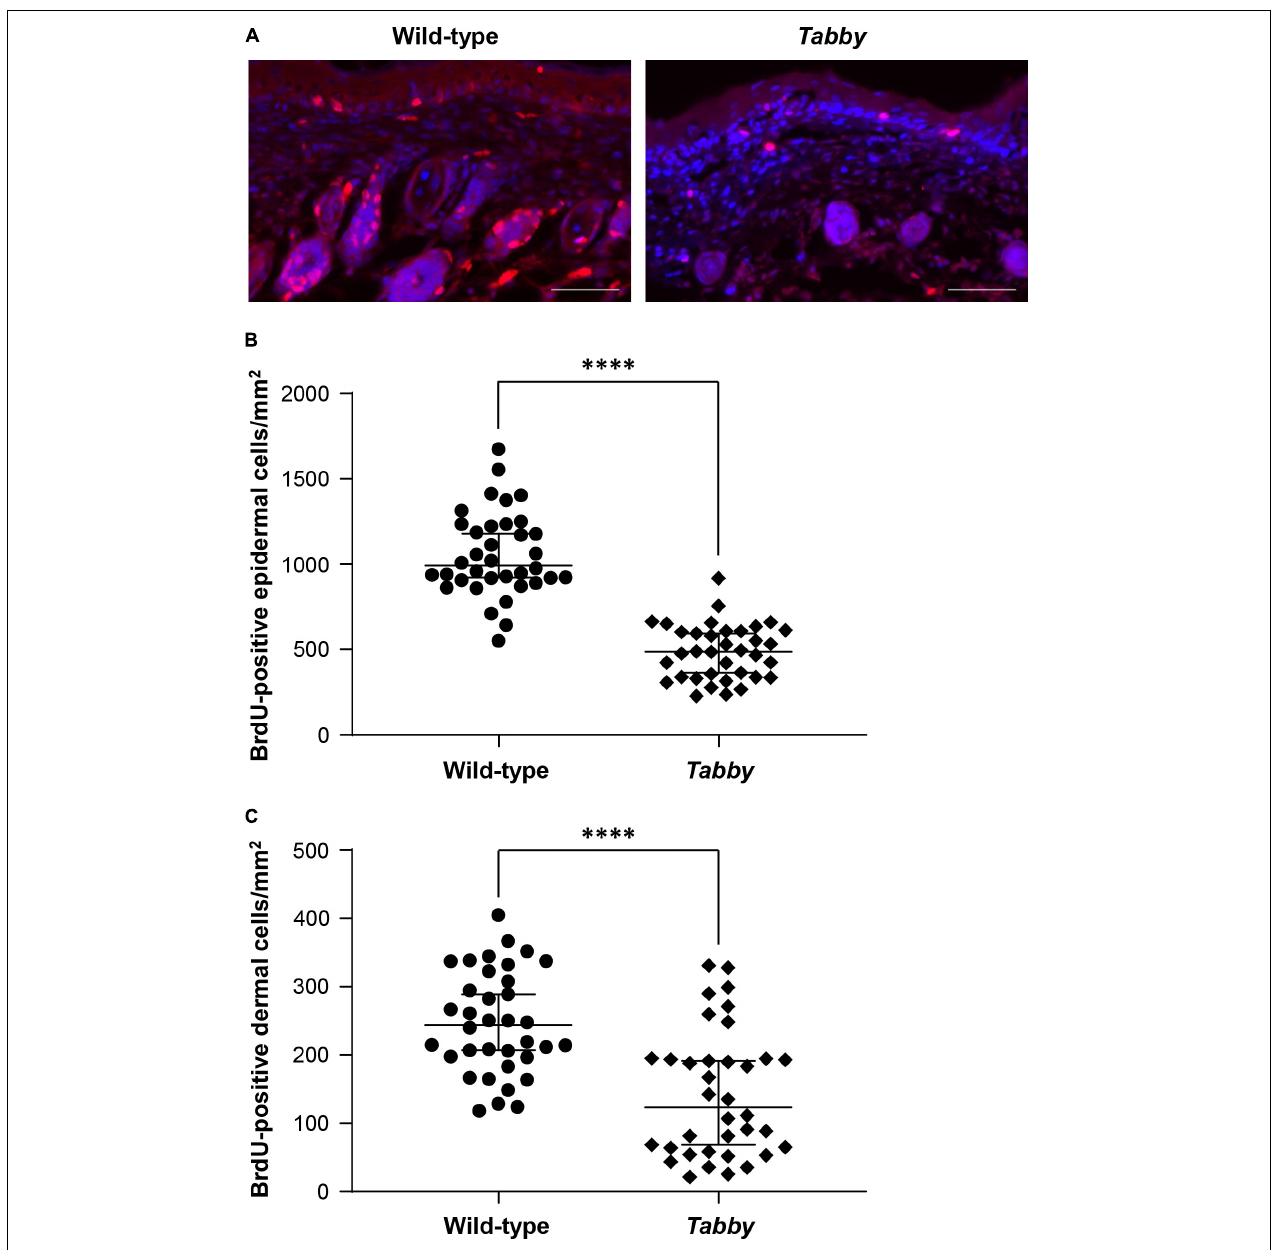
FIGURE 4 | Diminished proliferation of tail skin in Tabby mice. (A) Immunofluorescence staining of tail tip cross-sections from wild-type ( n = 6; left panel ) and Tabby mice ( n = 6; right panel ) after intraperitoneal injection of bromodeoxyuridine (BrdU) at day P9 to label replicating cells. The amount of BrdU-positive cells in the skin (red; nuclei counter-stained blue with DAPI) was assessed. (B,C) Quantitation of replicating cells visualized by BrdU incorporation. BrdU-positive nuclei were counted in the epidermis and the upper dermis (depth ≤ 0.15 mm) except for the hair bulb region. Data from six independent skin sections of each Tabby and wild-type mouse are shown. Scale bar: 50 µ m. ∗∗∗∗ p <